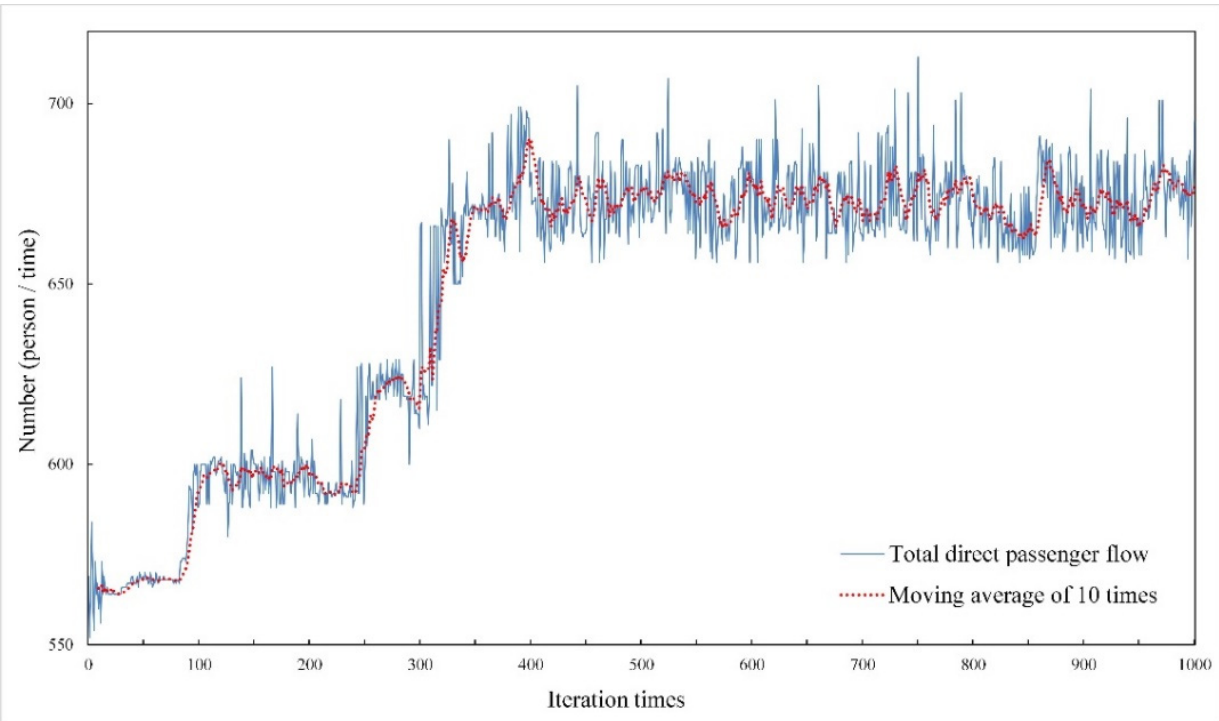
Figure 7. Trends of total direct passenger flow on planned line network.